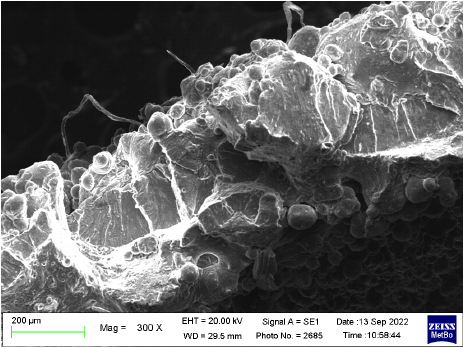
Figure 9. Final fracture surface of a 0.6 mm thick specimen as built